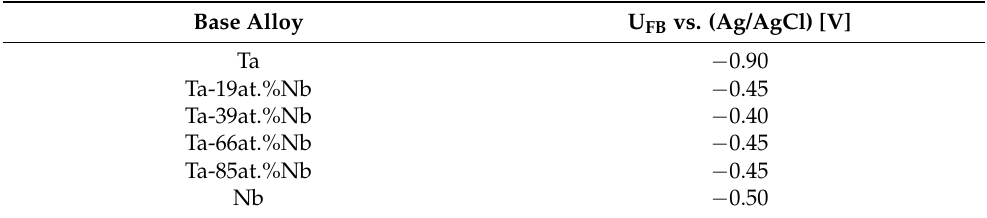
Table 3. Flat band potential values estimated with current transients recorded in 0.1 M ABE under constant irradiating wavelength relating to all the anodic oxides.